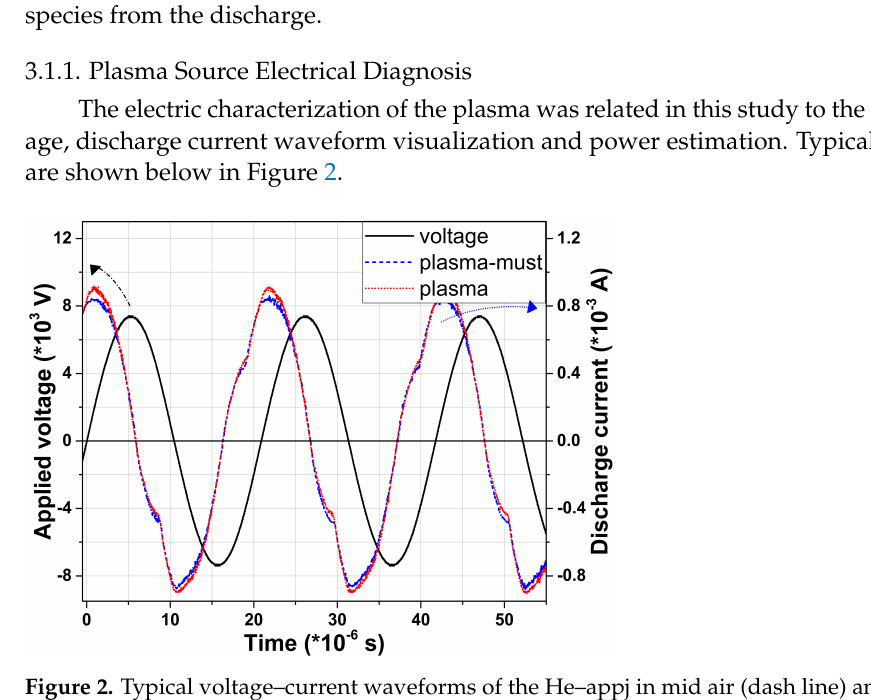
Figure 2. Typical voltage–current waveforms of the He–appj in mid air (dash line) and interacting with the withe must (short dot